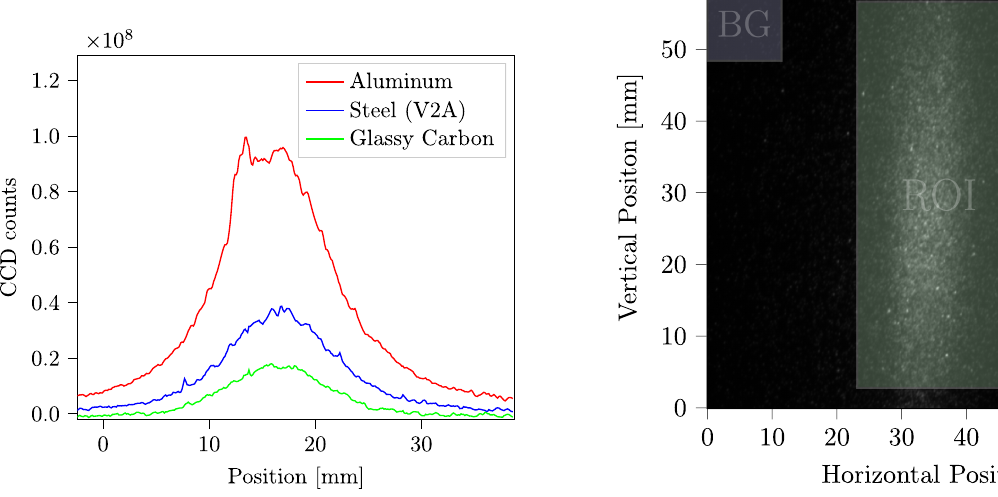
FIG. 7. Beam profile in horizontal plane for aluminum, steel, and glassy carbon targets for ψ ¼ 50 degrees for